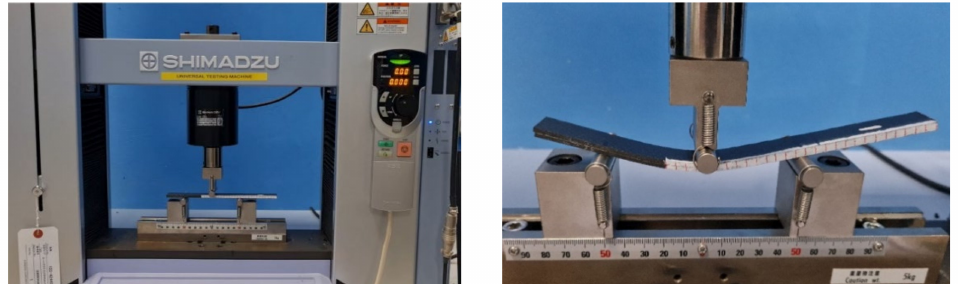
Figure 6. Experimental set up for the ENF specimen.